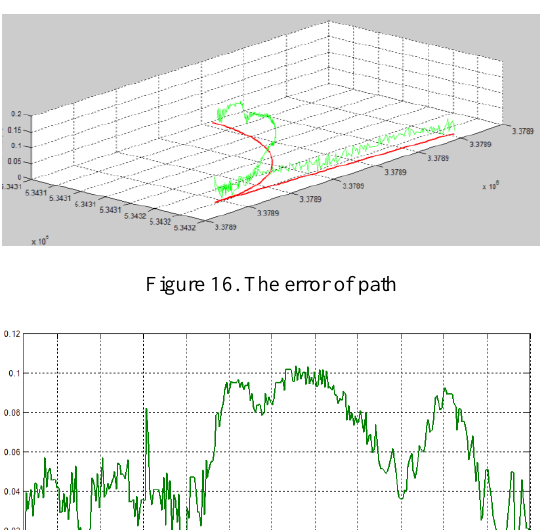
Figure 15. The processing of perpendicular parking